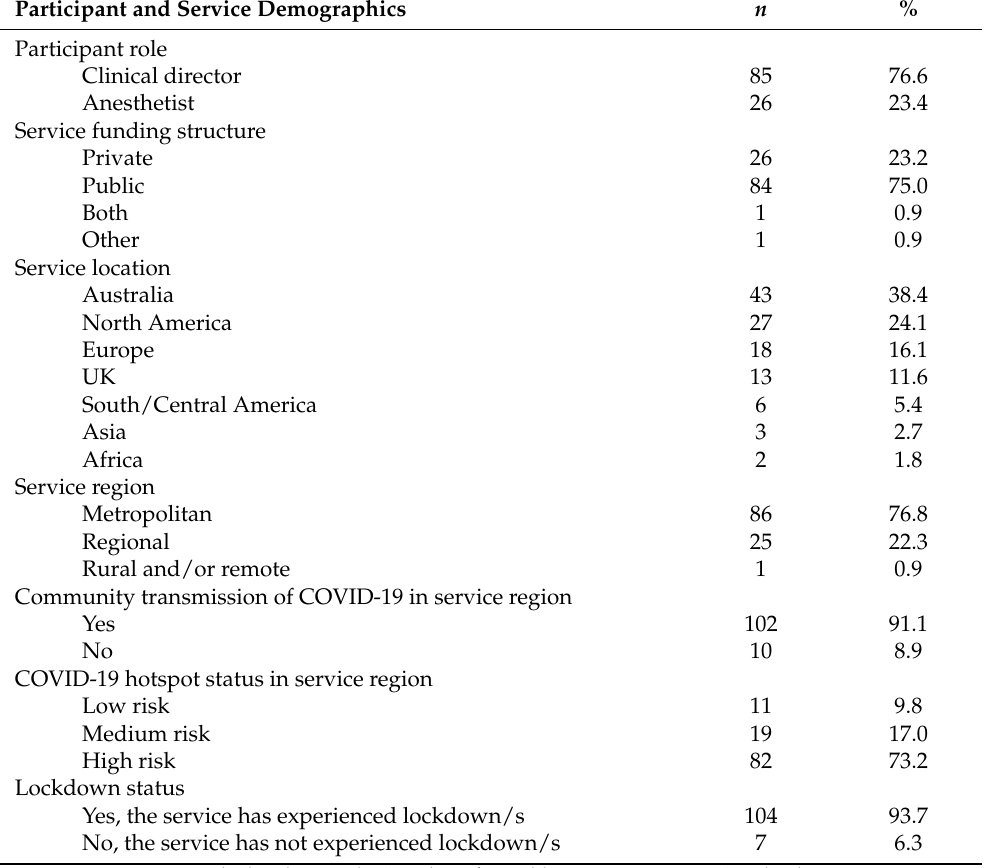
Table 1. Demographic information about survey respondents and their ECT